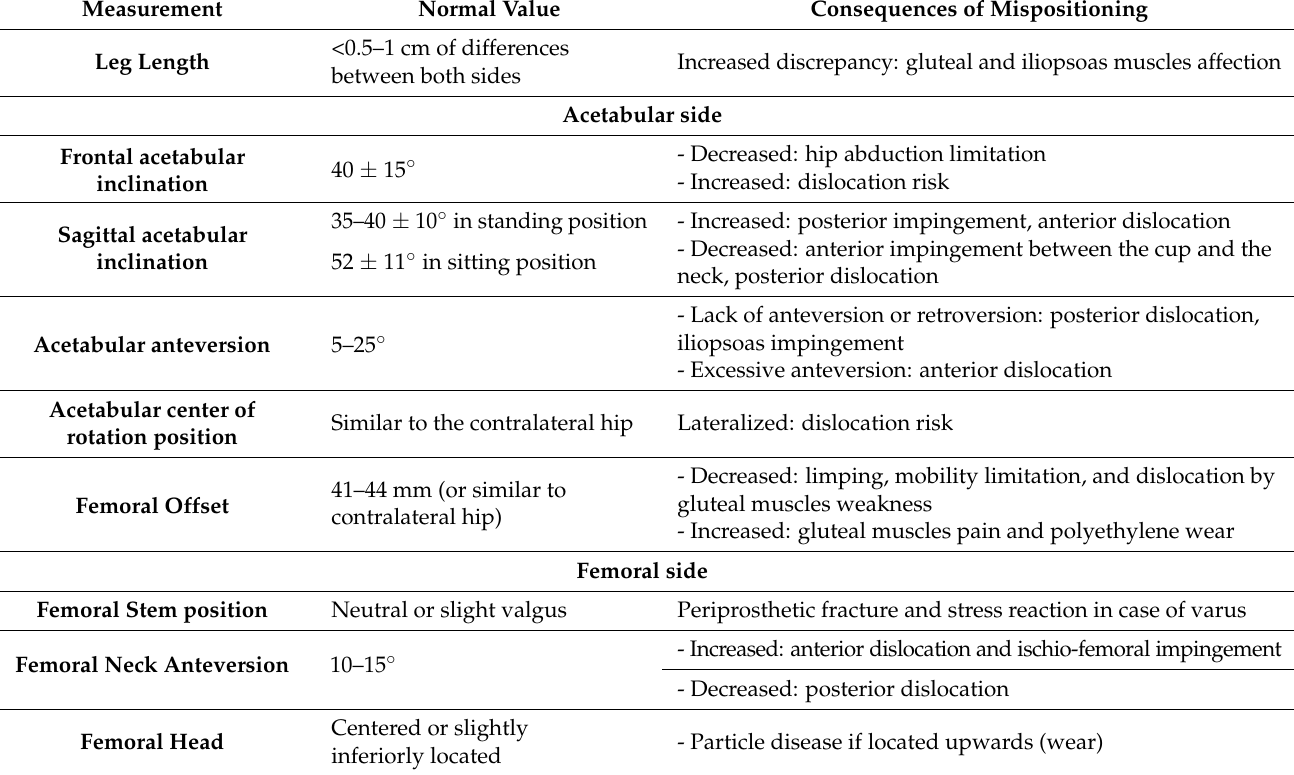
Table 1. Prosthetic implant positioning and their